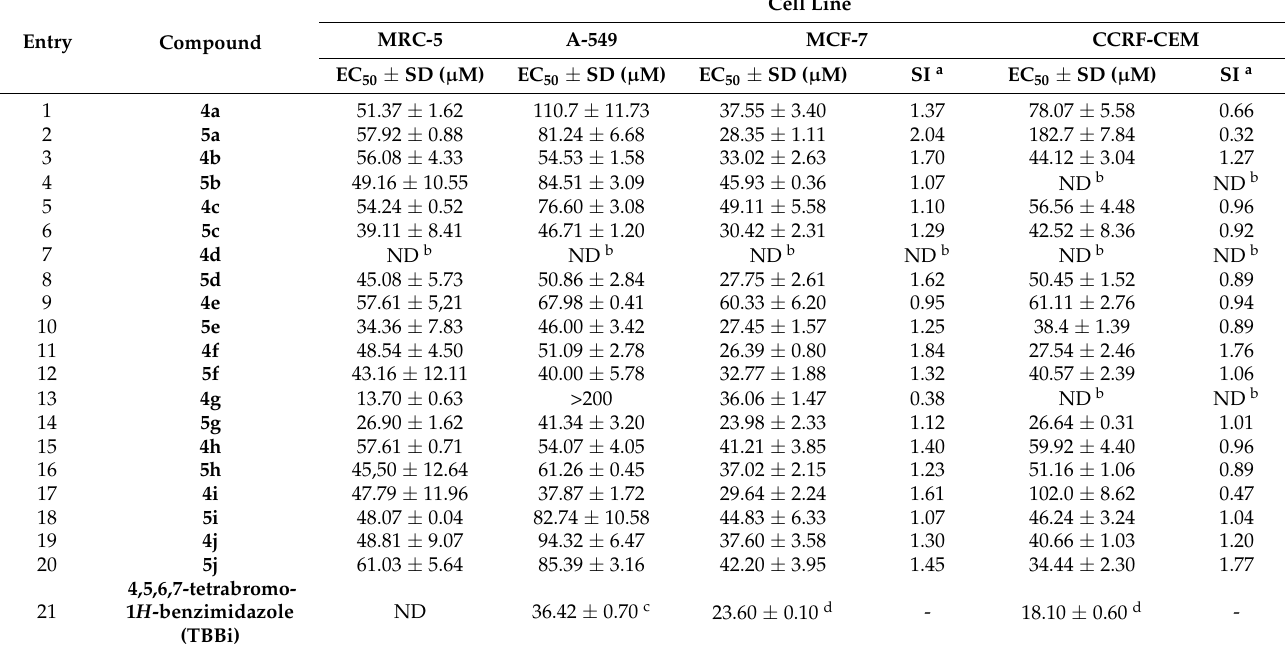
Table 4. Viability of MRC-5 (normal lung fibroblasts), MCF-7 (breast adenocarcinoma), A-549